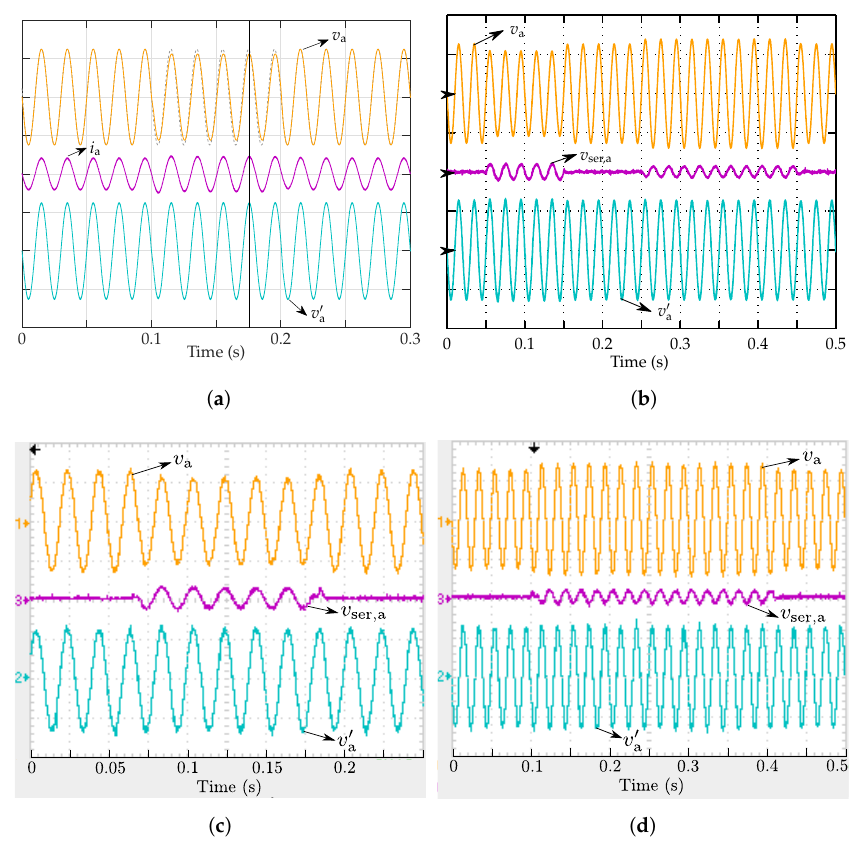
Figure 11. Results with voltage sag and swell: grid line-to-ground voltage v a , series compensation line-to-line voltage v ser,ab and load line-to-ground voltage v 0 a [125V/div] and grid line current i a [10A/div]. ( a ) Simulations: 10% sag from 0.1s to 0.2s with 10 degree phase-shift. ( b ) Simulations: 15% sag from 0.05s to 0.15s and 10% swell from 0.25s to 0.45s. ( c ) Experiments with 15% sag. ( d ) Experiments with 10% swell.